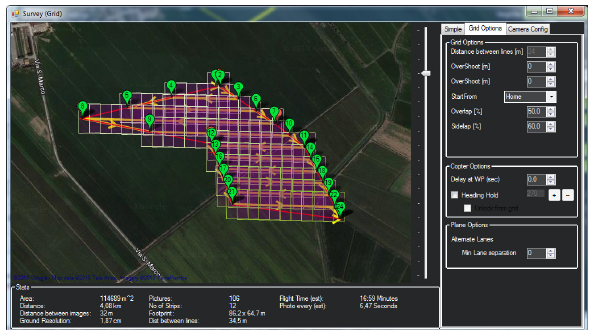
Figure 4: After defining a polygon, a right click on the map en- ables to start the Survey (Grid) widget (under auto wp ).